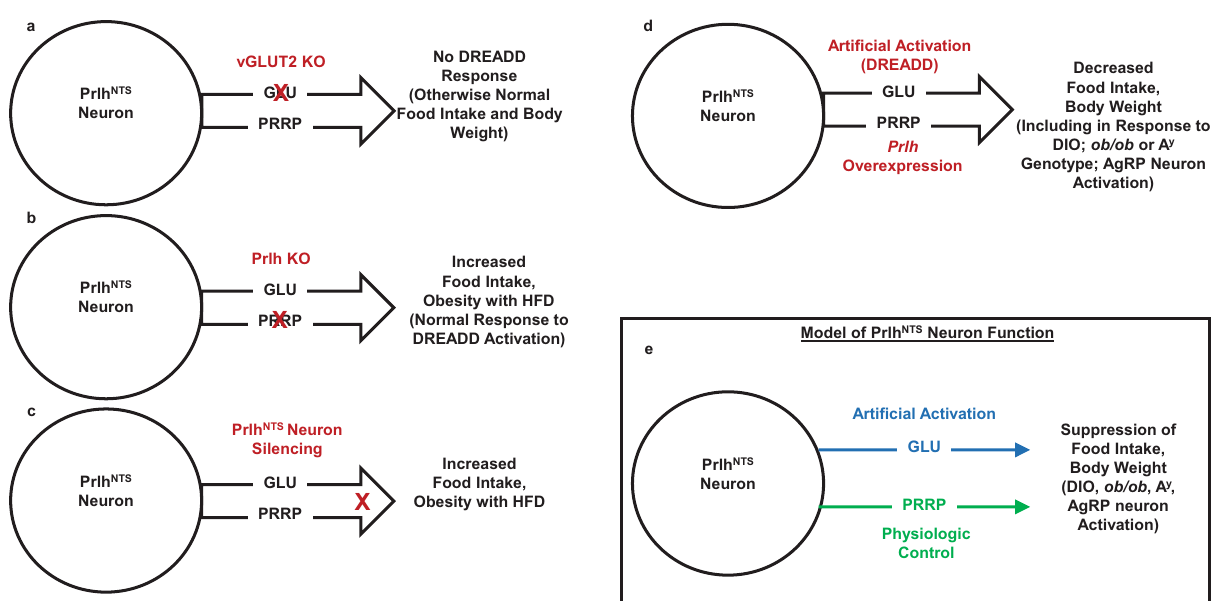
Fig. 7 Summary and model. Prlh NTS neurons utilize Glutamate (GLU) and PRRP as neurotransmitters. Ablation of vGLUT2 to abrogate GLU signaling blocks the suppression of food intake during DREADD-mediated activation of Prlh NTS cells, but does not alter energy balance ( A ). In contrast, ablation of Prlh in the NTS does not alter the response to DREADD-mediated activation, but promotes obesity on HFD ( B ). Silencing Prlh NTS neurons increases food intake and promotes obesity during HFD exposure ( C ). Increased signaling by Prlh NTS cells, either via DREADD-mediated activation or Prlh overexpression decreases food intake and body weight in response to multiple obesogenic perturbations, including HFD feeding, AgRP neuron activation, or ob/ob or A y genotype ( D ). Summary model is shown in ( E